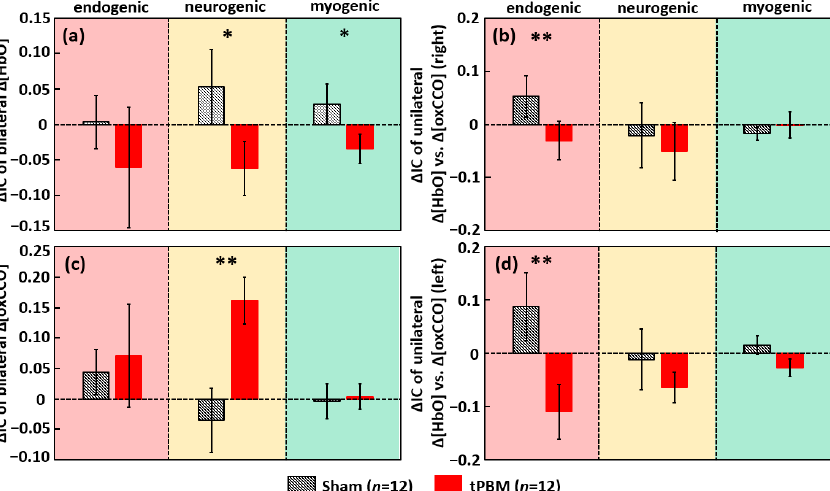
Figure 4. Baseline-subtracted changes of IC, Δ IC, for ( a ) bilateral Δ [HbO] coherence, ( b ) unilateral Δ [HbO] vs. Δ [oxCCO] coherence (right), ( c ) bilateral Δ [oxCCO] coherence, and ( d ) unilateral Δ [HbO] vs. Δ [oxCCO] coherence (left). tPBM- and sham-induced Δ IC values are marked by red and black bars, respectively ( n = 12). Error bars indicate the standard error of the mean in each case. The red, yellow, and green-shaded boxes denote the endogenic, neurogenic, and myogenic bands, respectively. “*” indicates p < 0.05, and “**” indicates p < 0.01 based on paired t -tests between tPBM and sham